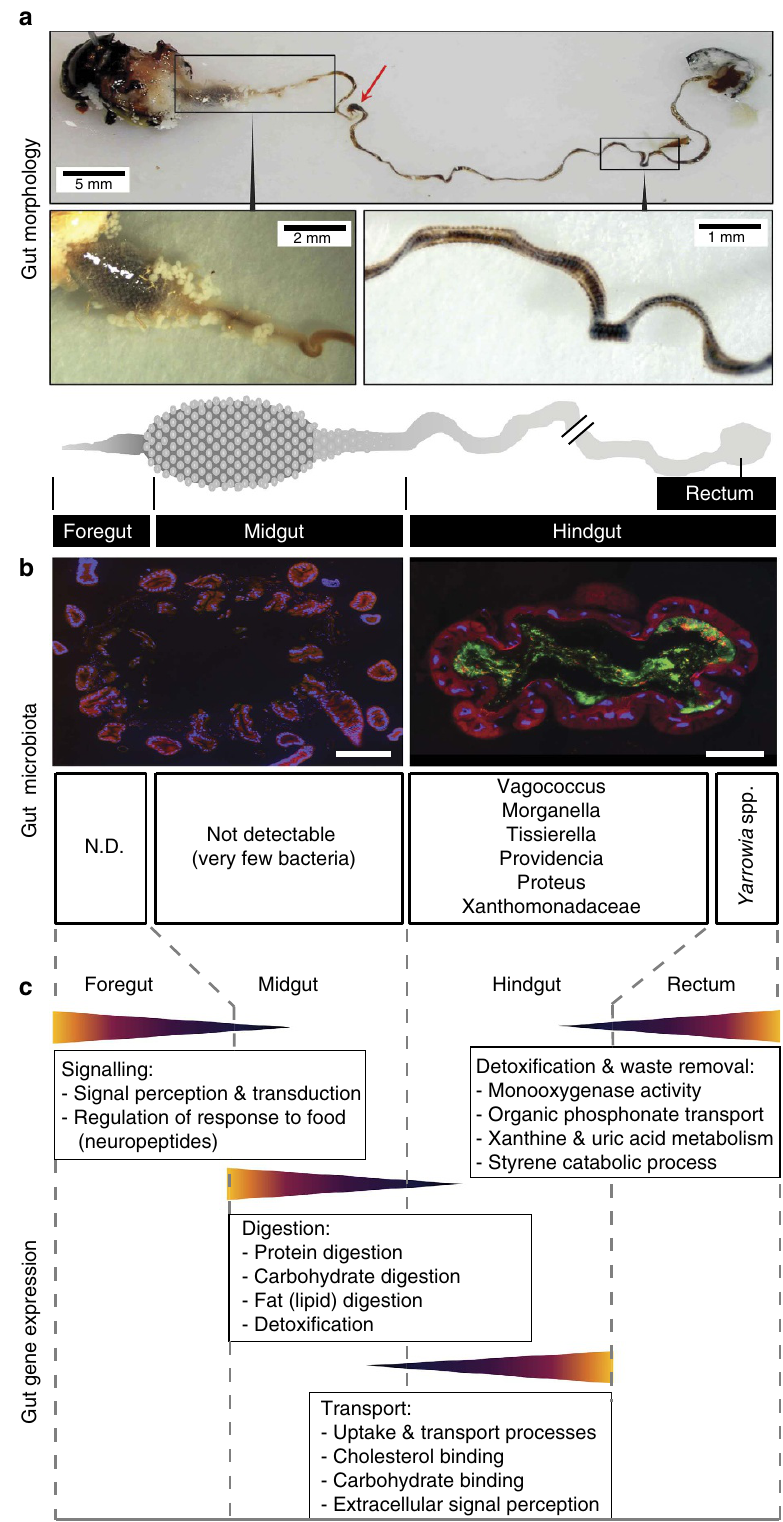
Figure 1 | Gut transcriptome and gut microbial community of N. vespilloides . ( a ) Morphology of a male N. vespillloides gut showing the complete gut structure as well as midgut and flat hindgut region with bulbous inflations. The red arrow indicates the position where the gut was separated into the midgut and hindgut portions during dissection. ( b ) Fluorescence in situ hybridization revealed some sections of the midgut with low (not detectable) bacterial prevalence, but a bacterially abundant hindgut region (bacteria stained with the general bacterial probe (green) EUB338-Cy5). Scale bars, 200 m m. ( c ) Differential representation of GO terms, reflecting metabolic differences between gut regions, with the foregut and midgut involved in signalling and digestion, the hindgut involved in the transport of nutrients and the rectum involved in waste removal and